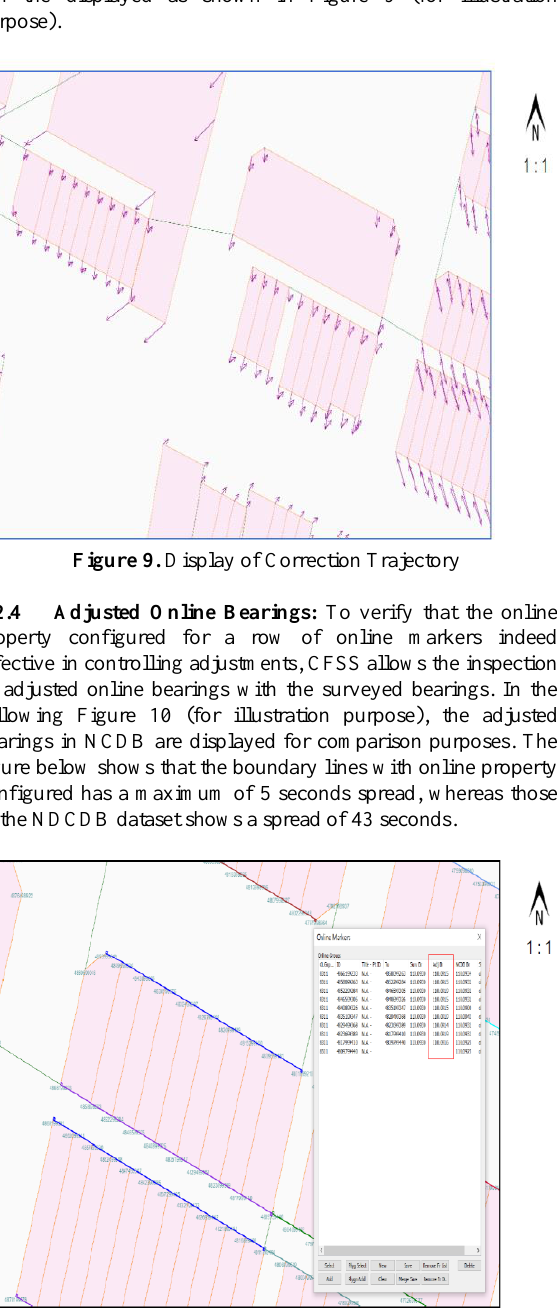
Figure 10. Display of Online Adjustment